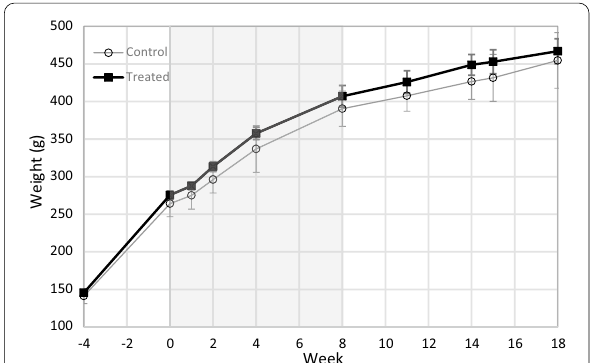
Fig. 2 Weight gain of the PET‑imaged animals in Set A ( n were no significant differences between the control ( n week 4) and treated ( n 4) animals at the individual time points = using multivariate analysis. The results are presented as mean (SD). The DMF treatment period is indicated as grey